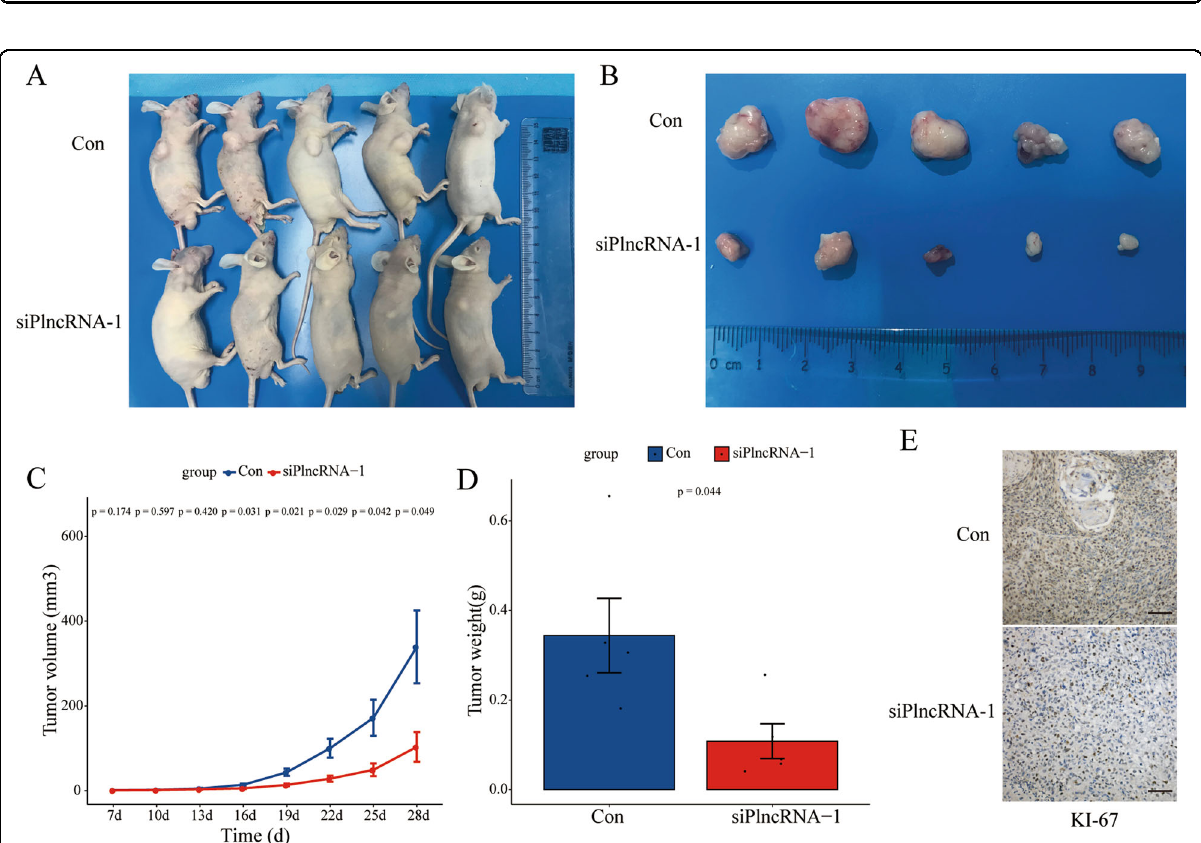
Fig. 3 Xenograft tumor formation of 5647 cells in PlncRNA-1-silenced nude mice. A Photograph of xenografted tumors in nude mice on day 28. B Pictorials of subcutaneous tumors on day 28. C Growth curves for xenografted tumors. D The tumor weights of different groups. E Immunohistochemistry assay for the expression of Ki-67 in the tumor xenografts (Scale bar, 100 μ